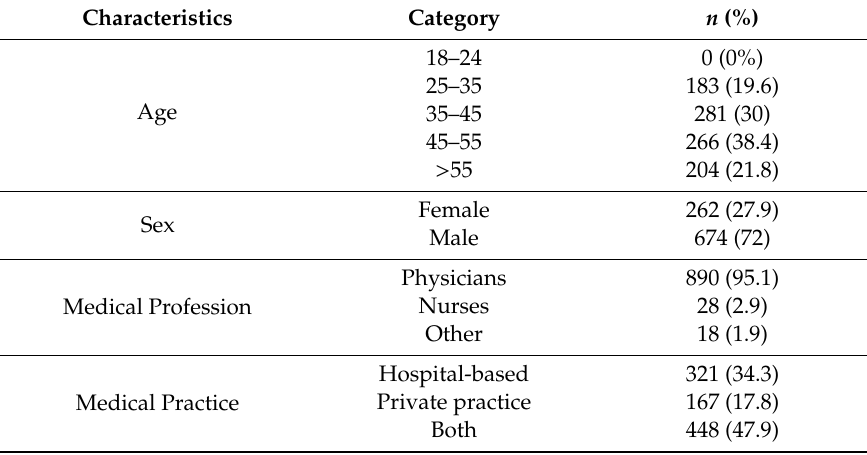
Table 1. Demographics and characteristic of the healthcare